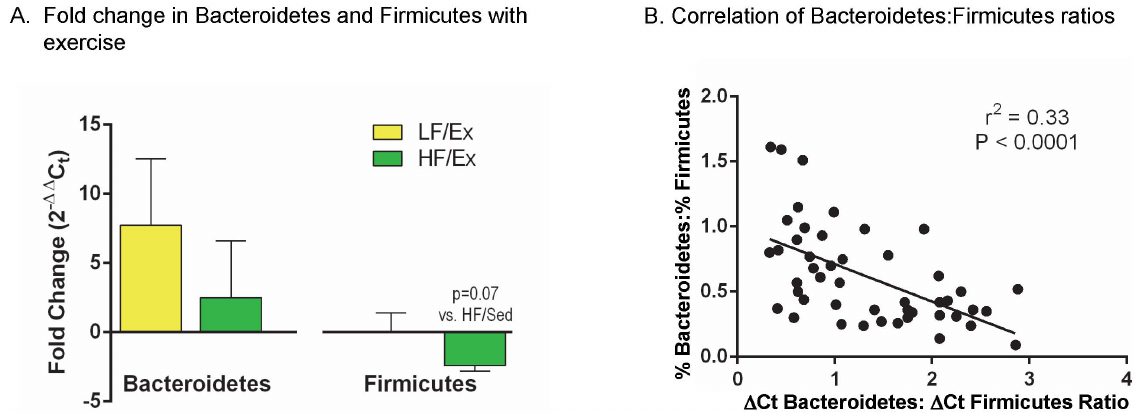
Figure 5. Diet and Activity Altered the Relative Level of Bacteroidetes and Firmicutes. A. The fold change in Bacteroidetes and Firmicutes was determined from the 2 2 DD Ct values calculated from the D Ct values generated by quantitative polymerase chain reaction (qPCR) using primers specific to each phyla (one-way ANOVA). B. Criterion validity of qPCR was examined by correlating the D Ct-Bacteroidetes: D Ct-Firmicutes ratio with the %-Bacteroidetes: %- Firmicutes ratios from sequencing. Data was analyzed by Pearson product-moment correlation coefficient and alpha level of p , 0.05.